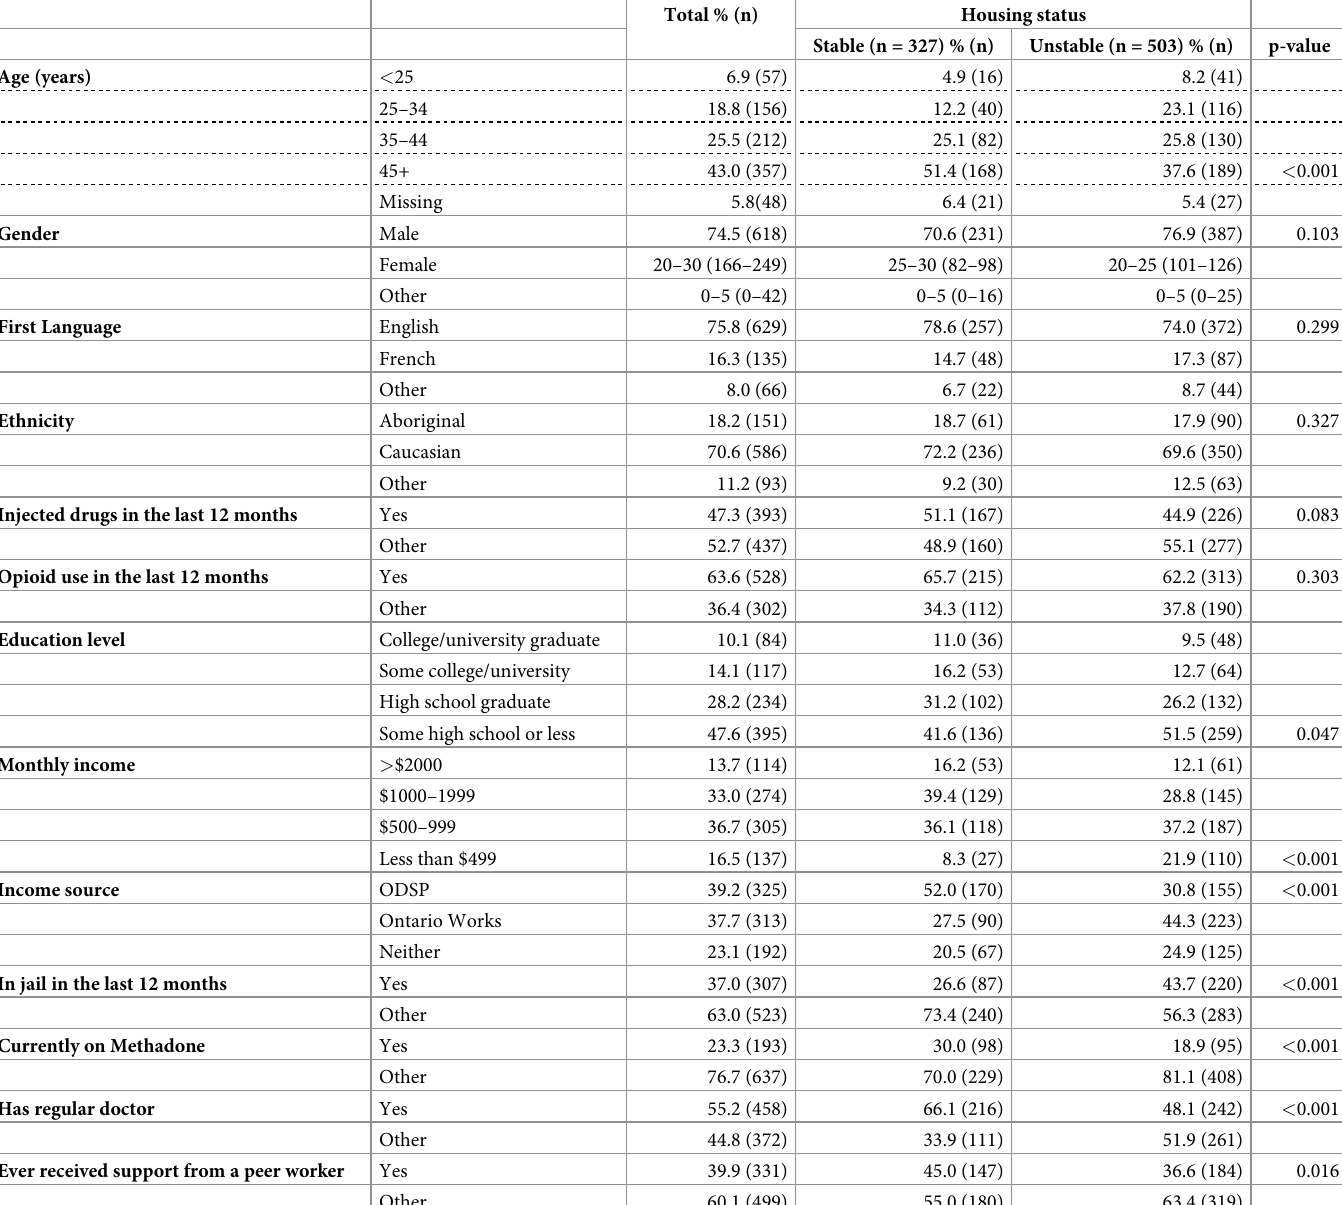
Table 1. Characteristics of participants stratified by housing status (n =